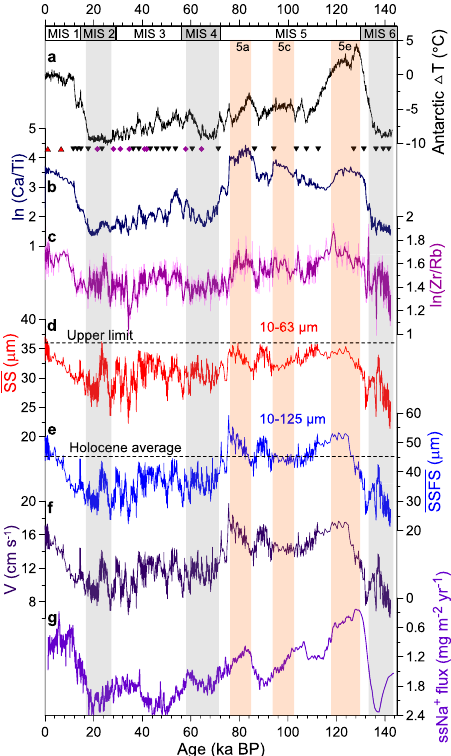
Fig. 2 Reconstructed changes in ACC strength and compared with Antarctic temperature and Southern Ocean sea-ice extent. a Antarctic temperature changes from the European Project for Ice Coring in Antarctica (EPICA) Dome C ice core 47 . b High-resolution XRF scanner-derived records of ln(Ca/Ti) (peak area count ratios; black triangles) were applied to fi ne- tune the Antarctic temperature anomalies together with radiocarbon dates (red triangles), relative paleointensity and paleomagnetic excursions (purple diamonds) age control points from core PS97/085-3 (see Supplementary Methods, Supplementary Figs. 2 and 3). c XRF-derived ln (Zr/Rb) variations indicate changes in sediment grain-size fractions. d Mean sortable silt grain size (SS, 10 – 63 μ m) reaches up its upper limit under high fl ow speeds. e Mean grain size of sortable silt and fi ne sand (SSFS, 10 – 125 μ m) was used as the ACC fl ow speed proxy in this study. f ACC bottom fl ow speeds were estimated by the correlation between the SSFS and adjacent current meter data (see Supplementary Fig. 6). g Sea salt sodium (ssNa + ) fl ux from the EPICA Dronning Maud Land (EDML) ice core, a proxy for sea ice extent and atmosphere changes, smoothed with a three-points running mean 34 . Vertical gray bars mark inferred glacial periods and pink bars indicate the sub-interglacial during Marine Isotope Stage (MIS) 5.